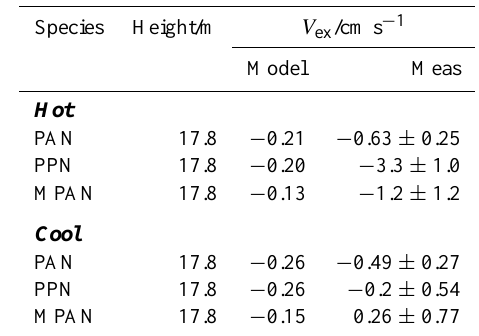
Table 8. Model-measurement comparison of APN exchange veloc- ities. All measurements are from 17.8 m and are given as the mean ± 1 σ . Model results are from the layer closest to the measurement